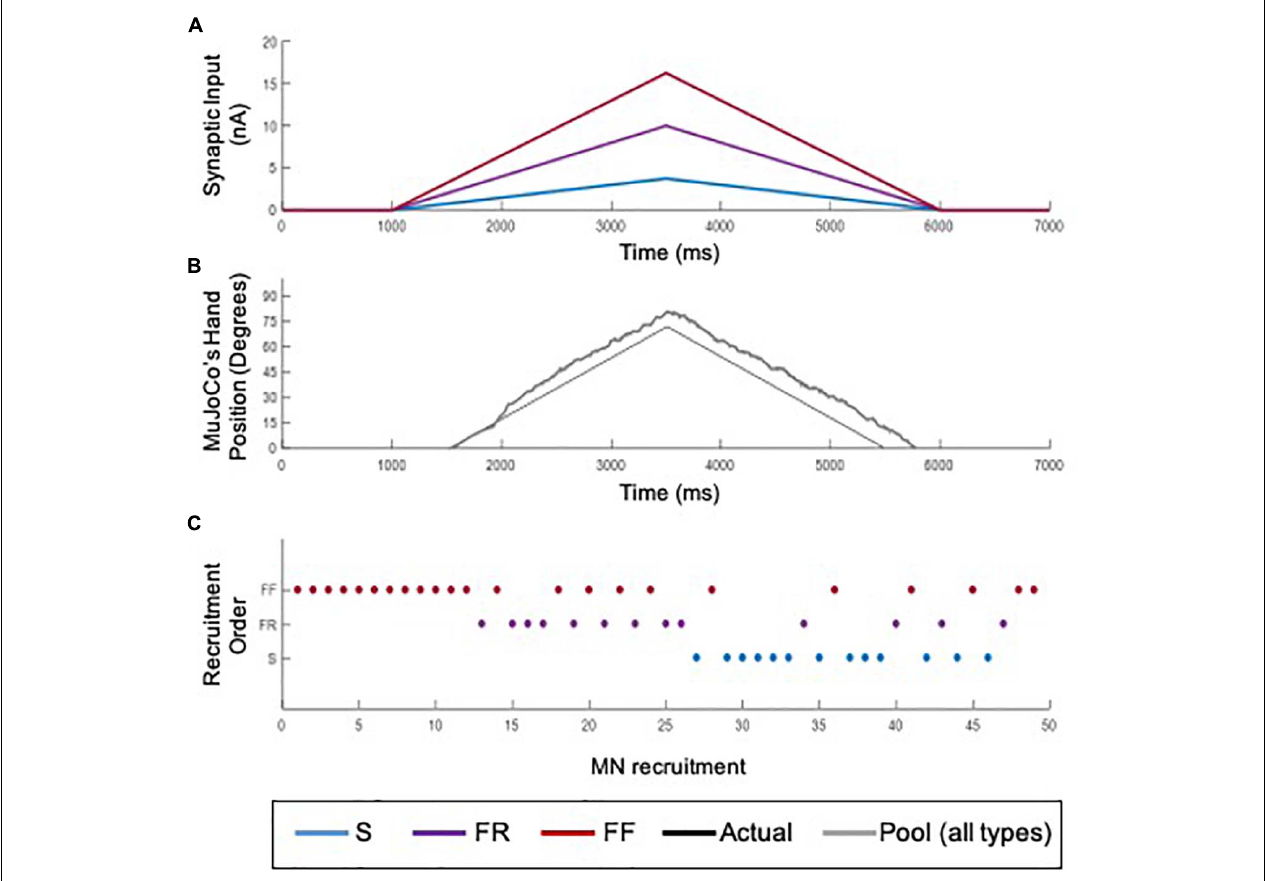
FIGURE 9 | Testing of the adaptive 3-speed decoder with the firing output of a reversely recruited MN pool. (A) The synaptic input to MNs in the pool model. A non-uniform input activated S-MNs to a peak value of 3.75 nA (blue), FR-MNs to a peak value of 10 nA (purple), and FF-MNs to a peak value of 16.25 nA (red). (B) Recruitment order of MNs in the pool. The non-uniform input recruited MNs opposite to the size principle: FF-MNs first, followed by FR, then S-MNs. (C) Comparison of MuJoCo’s hand position when driven by the actual input (black) vs. the input decoded from the aggregate firing of reverse recruitment pool